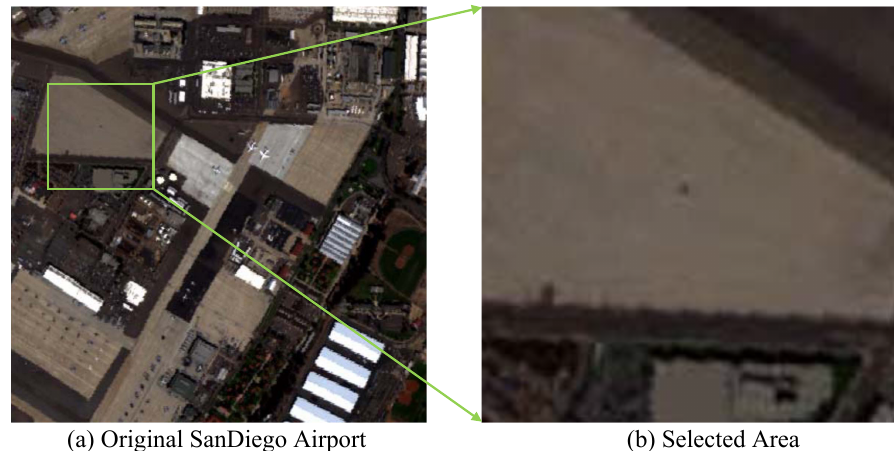
Figure 2. San Diego Airport Dataset.